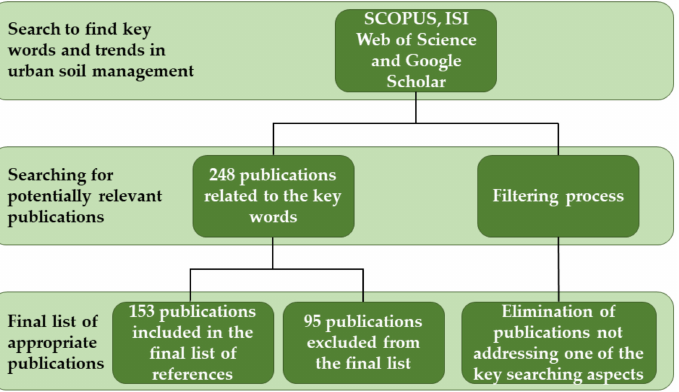
Figure 1. Literature review